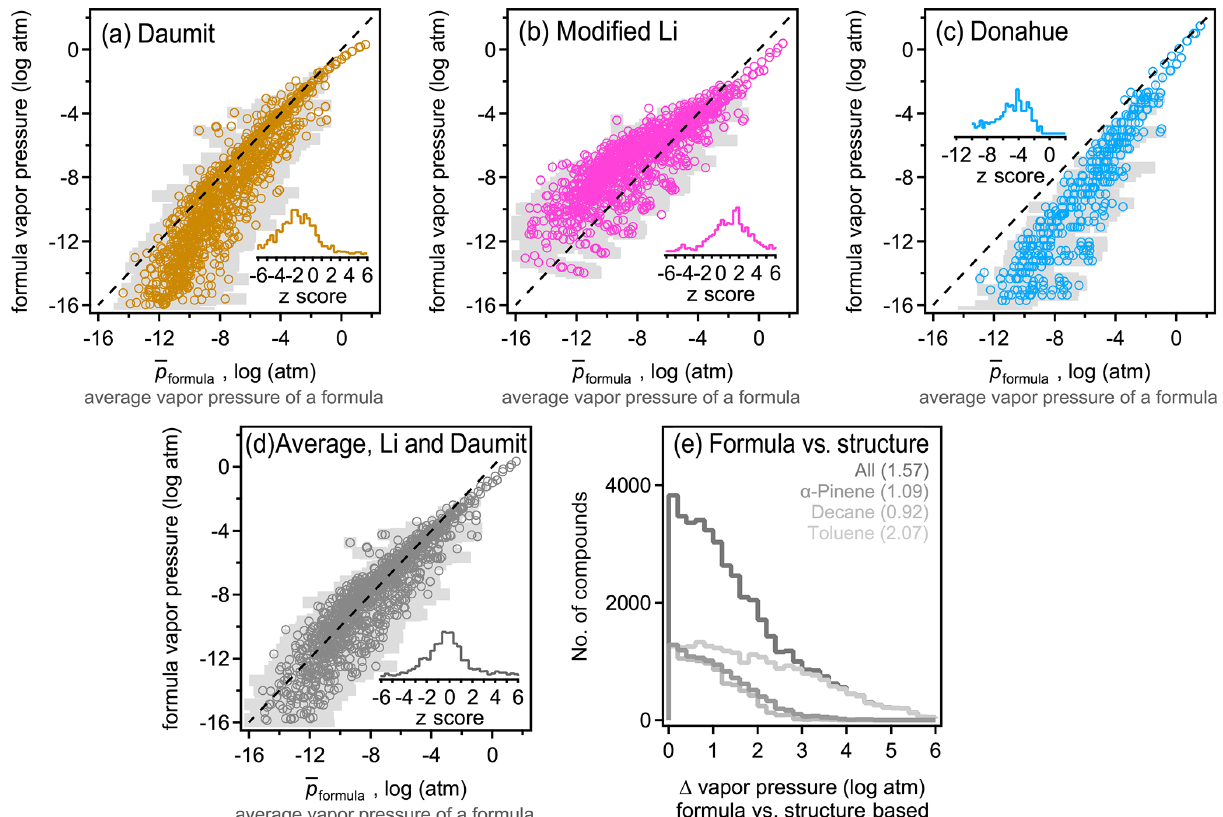
Figure 3. Comparison between average vapor pressure of a formula p formula (average of all methods and all isomers; see the text) and the formula-based estimate using the (a) Daumit method, (b) Li method, modified to remove its bias for nitrates, (c) Donahue method, and the (d) average of the Daumit and modified Li methods. Each formula is represented as an open circle at p formula , with light gray bars representing a standard deviation of the average, σ p , to indicate the approximate range. Insets are distributions of z scores for each method, calculated as the difference between the formula-based method and p formula , relative to the standard deviation of p formula . (e) Distribution of error from applying the average Daumit–Li method to any given compound, with each oxidation system shown in a different shade (gas and particle phases combined). Average values of each distribution are provided in